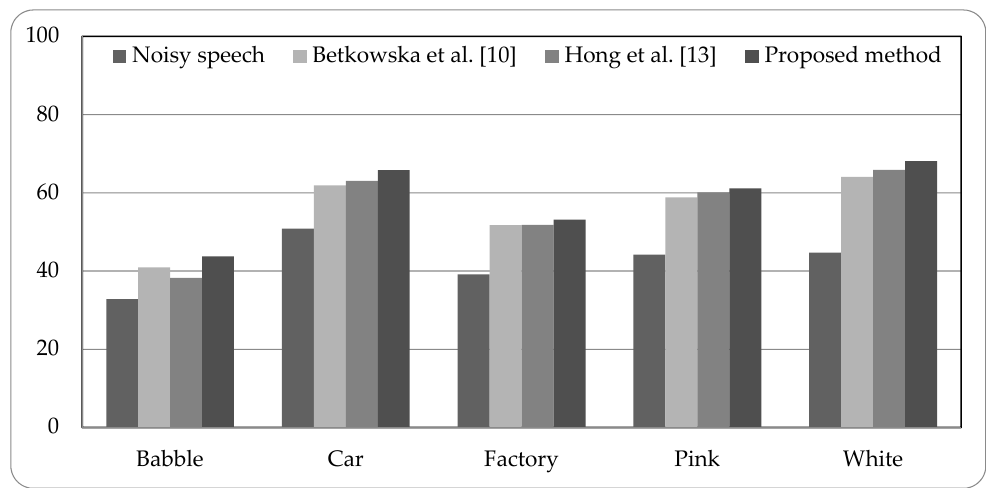
Figure 6. Speech recognition rates of noisy speech (5 dB), related works, and proposed method. Sensors 2018 , 18 , x FOR PEER REVIEW